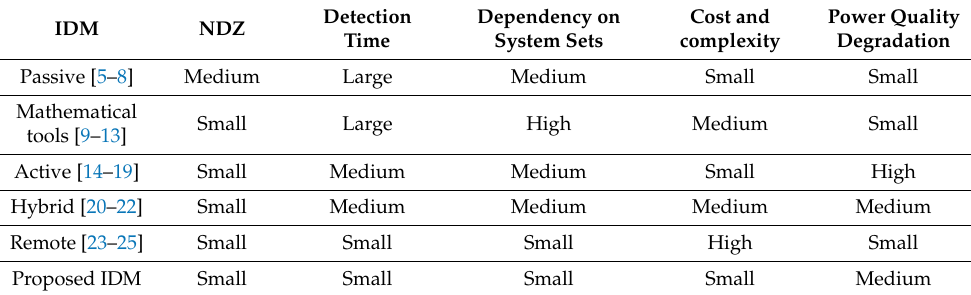
Table 5. Comparison assessment of the proposed technique with the existing